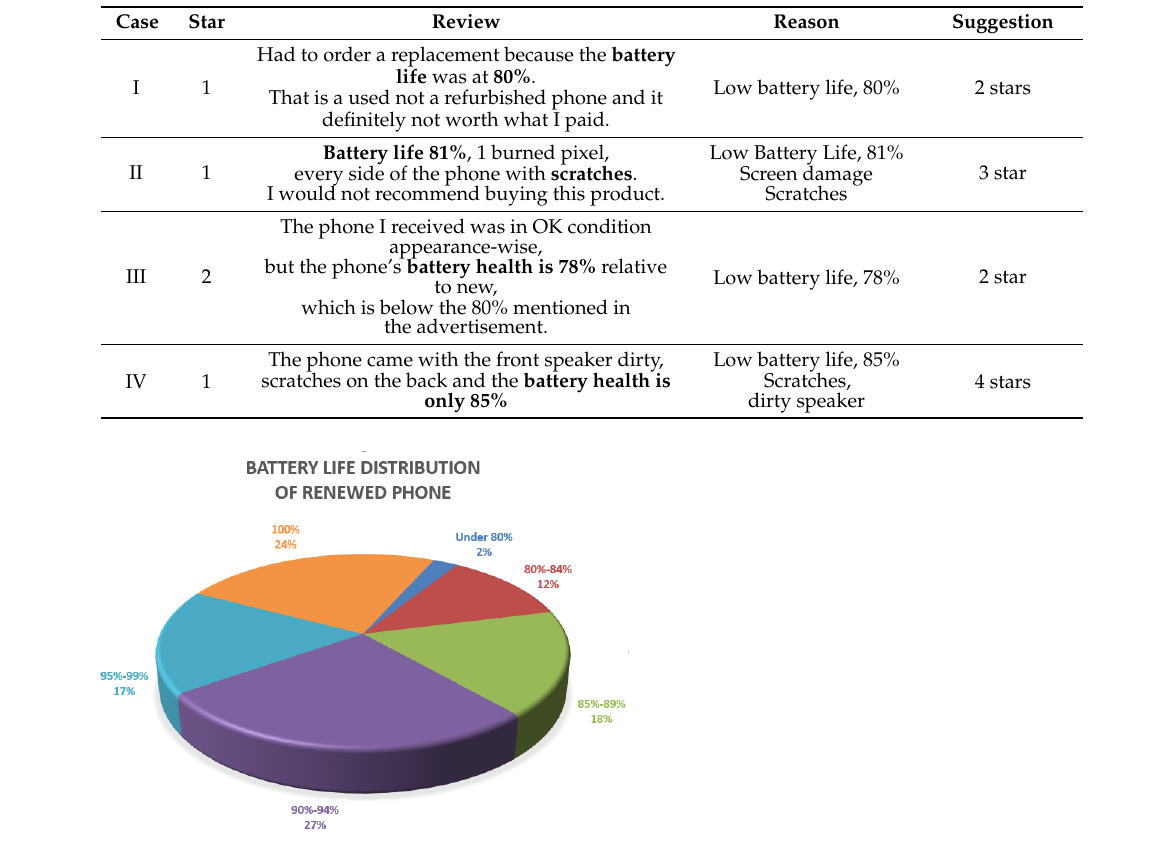
Figure A8. Battery Life Distribution of Renewed